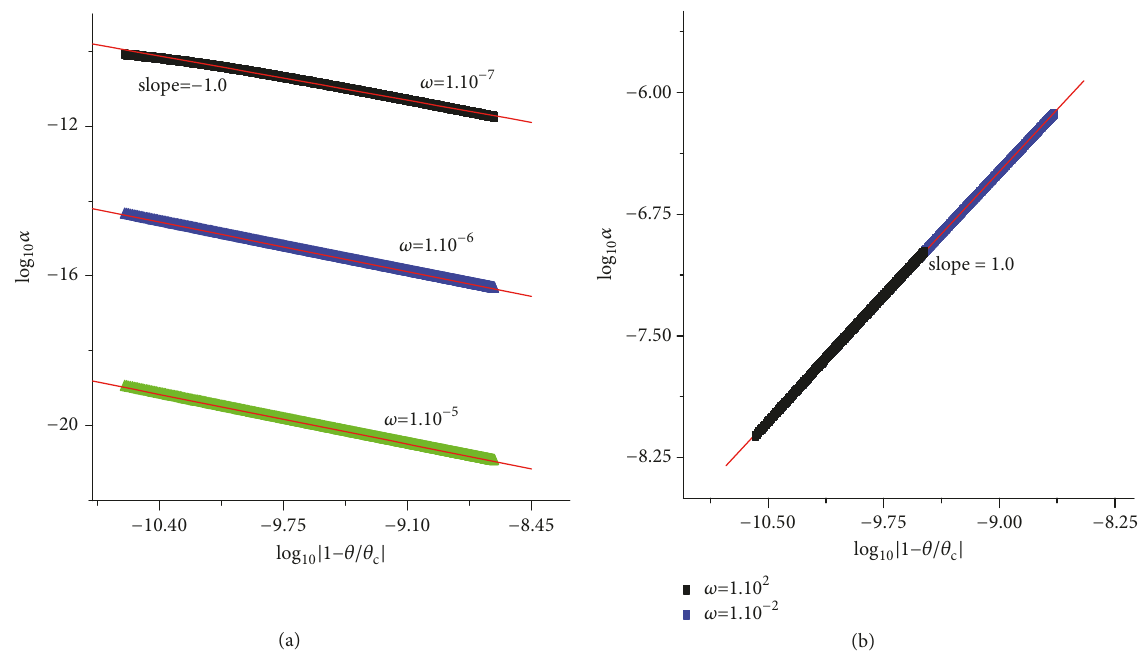
Figure 5: Double logarithmic plots of attenuationversus |1−𝜃/𝜃 𝐶 | for (a)low-frequencyand (b)high-frequencyregimes inthe neighborhood of a critical point for 𝑝 = 0.98 , 𝑑 = 𝑑 𝐶 = 0.45 , and 𝐿 = 0.02 .